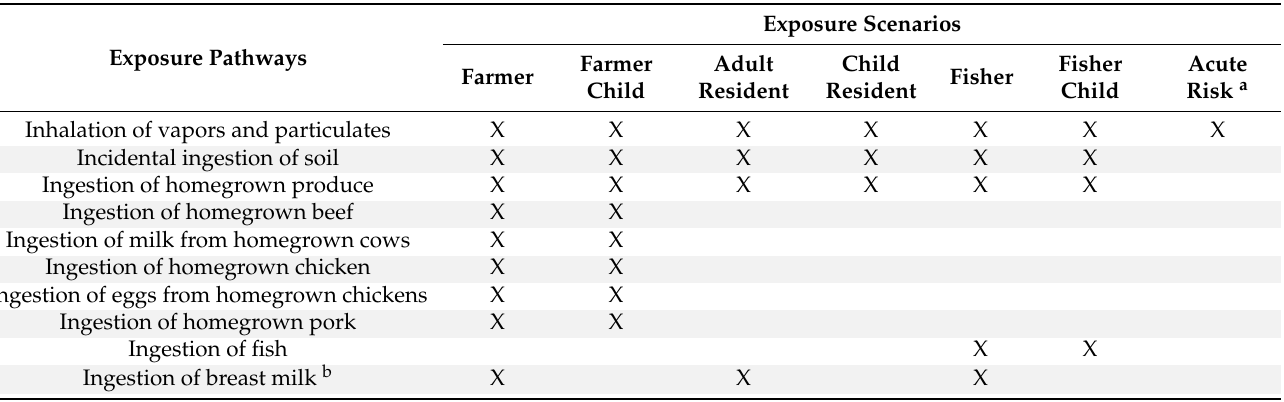
Table 4. Selected exposure scenarios and associated exposure pathways considered in the present